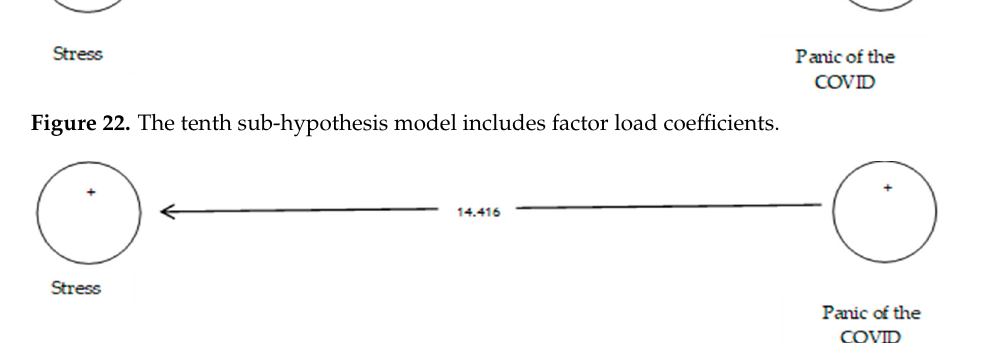
Figure 23. Drawn model with significant coefficients z. Table 14. Evaluation indicators of the internal model of the research, direction and significance of direct effects.